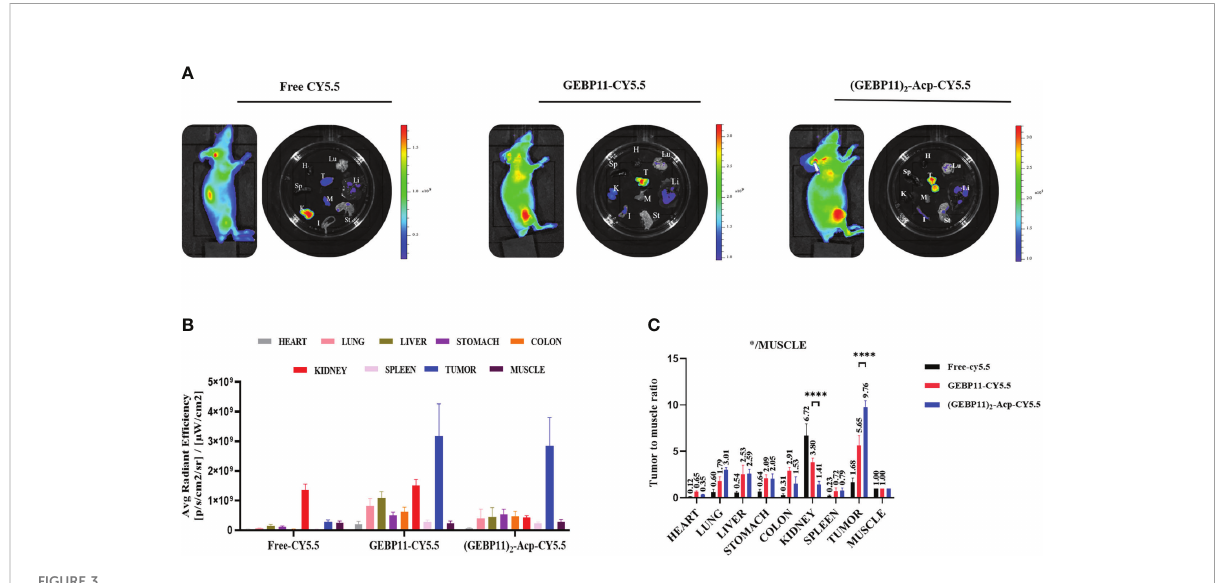
FIGURE 3 Biodistribution study of free Cy5.5, GEBP11-Cy5.5 and (GEBP11) 2 -Acp-Cy5.5 group in vivo . (A) Representative fl uorescence images of the subcutaneous tumor-bearing mice and excised organs at 24 h post-injection, Color bar Units: [p/s/cm 2 /sr]/[ m W/cm 2 ]. (B) Average signal intensity of main organs in each group of mice. (C) Quanti fi cation of SBR pro fi les (tumor to muscle) of nude mice administered GEBP11 series probes at 24h. **** P < 0.001, n=3. *Abbreviation label of main organs: H, Heart, Lu, Lung, K, Kidney, Mu, Muscle; Sp, Spleen; Li, Liver; In, Intesinal; G, Gastric; T, Tumor.